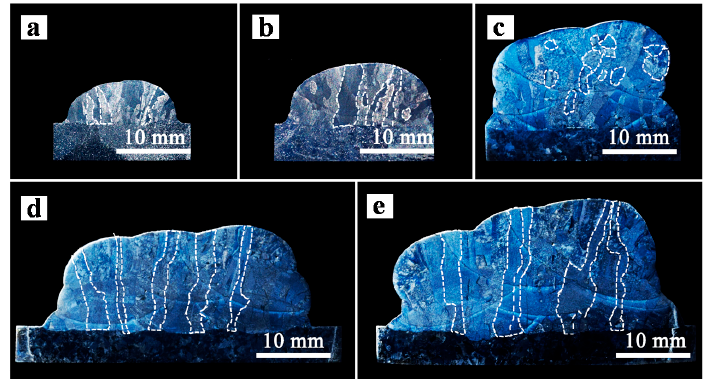
Figure 5. Macroscopic grain morphology of blocks manufactured at the wire feed speed (WFS) of Table 2. Macroscopic parameters at different WFS.